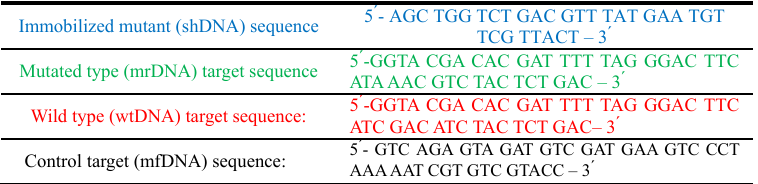
Table 2 Sequence orientation of adenine (A), thymine (T), guanine (G), and cytosine (C) sequence in BRCA2 (6174delT). Immobilized mutant (shDNA)